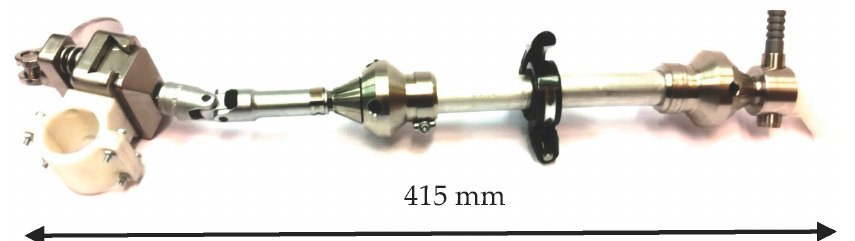
7 of 11 Figure 6. Final prosthesis design (assembled view). Figure 7. Final prosthetic design (exploded view): ( a ) Handlebar Connection; ( b ) Spring plunger release system; ( c ) Middle-block; ( d ) Slider; ( e ) Universal joint (with custom restrictor); ( f ) Male tube clamp adapter; ( g ) Female tube clamp adapter joint; ( h ) Lower-middle pylon; ( i ) Clamp release; ( j ) Upper-middle pylon; ( k ) Female tube clamp adapter joint; ( l ) Male tube clamp adapter; ( m ) Plastic cast; ( n ) Iceross Sport Liner. The design is intended to compliment commercially available products, such as the Iceross Sport Liner. These liners are fitted with a locking mechanism, which involves a pin connecting to a plastic cast adapter, to form a secure and comfortable connection. Components (a)–(c) in Figure 7 will be attached to the bicycle handlebar, while components (d)–(n) will be attached to the rider. Table 2 shows a breakdown of the manufacturing details relating to the components in Figure 7. Most parts were manufactured ‘in-house’ by workshop technicians at the School of Engineering. Pyramid connectors are standardised components used in a variety of prosthetic designs. These